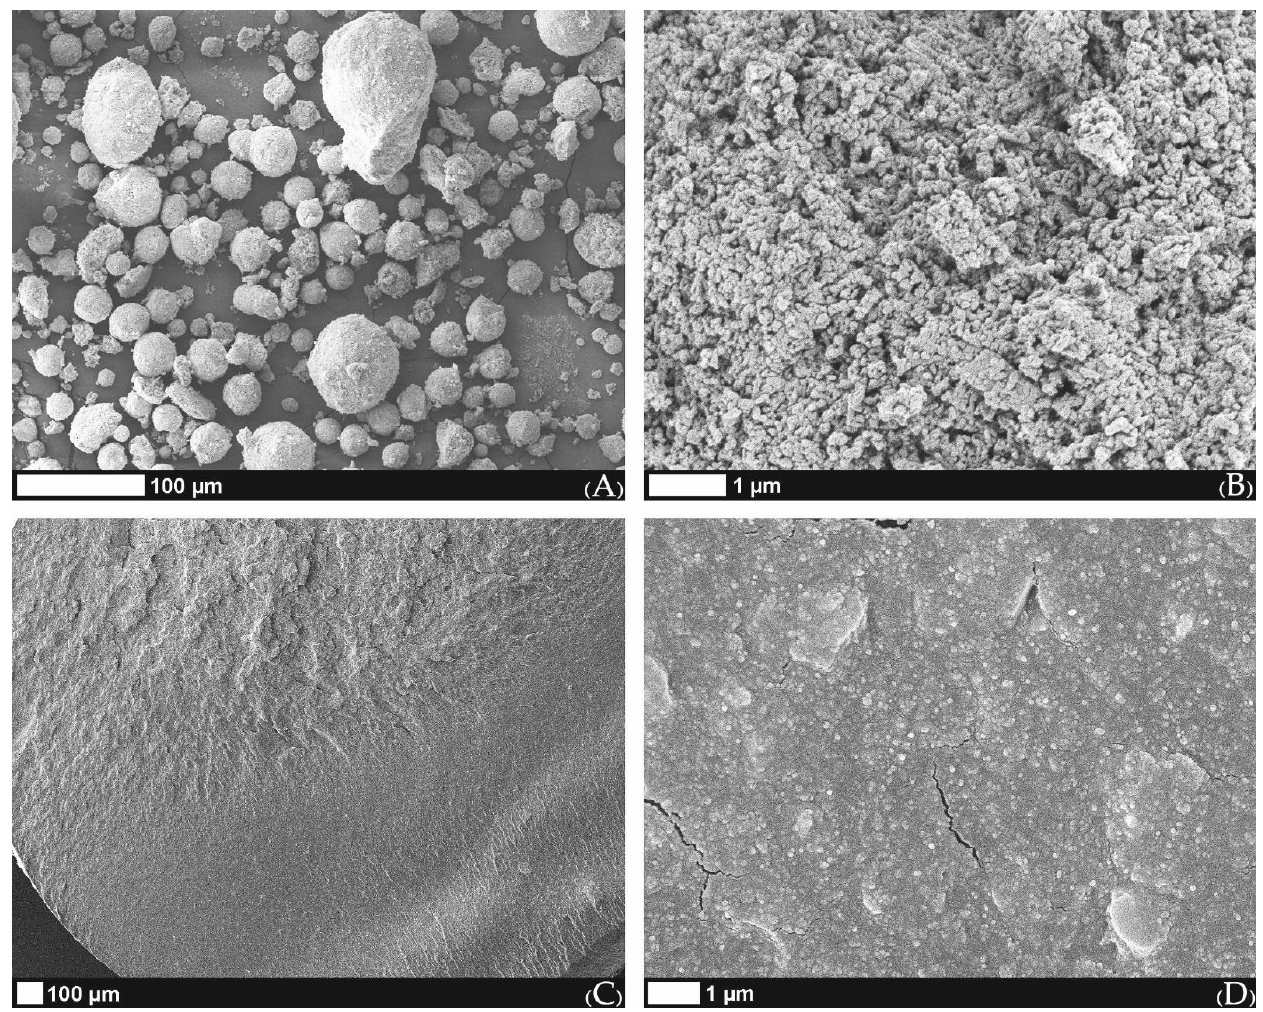
Figure 4. SEM images of ( A ) spherical aggregates of used CDHA; ( B ) enlarged surface image of the CDHA aggregate; ( C ) filament fracture surface; ( D ) enlarged fracture surface image with several fissures produced during filament fracturing under cryogenic conditions.